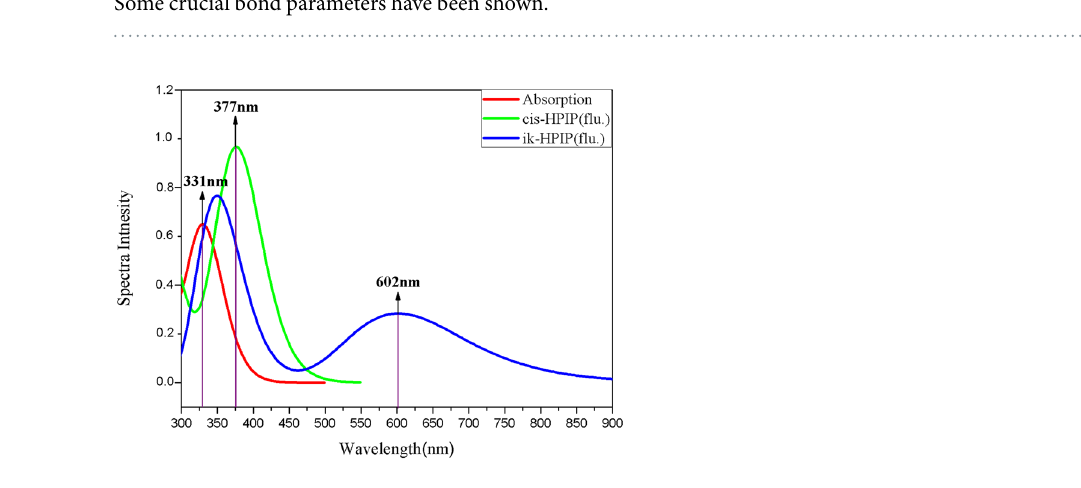
Figure 4. Theoretically simulating the absorption and fluorescence spectra of the HPIP in the PCM solvation, the violet vertical lines stand for the corresponding peak values in the theoretical calculation discussed by Toshiki Mutai et al . The detail explanations of curves can be given by the legend on the top right